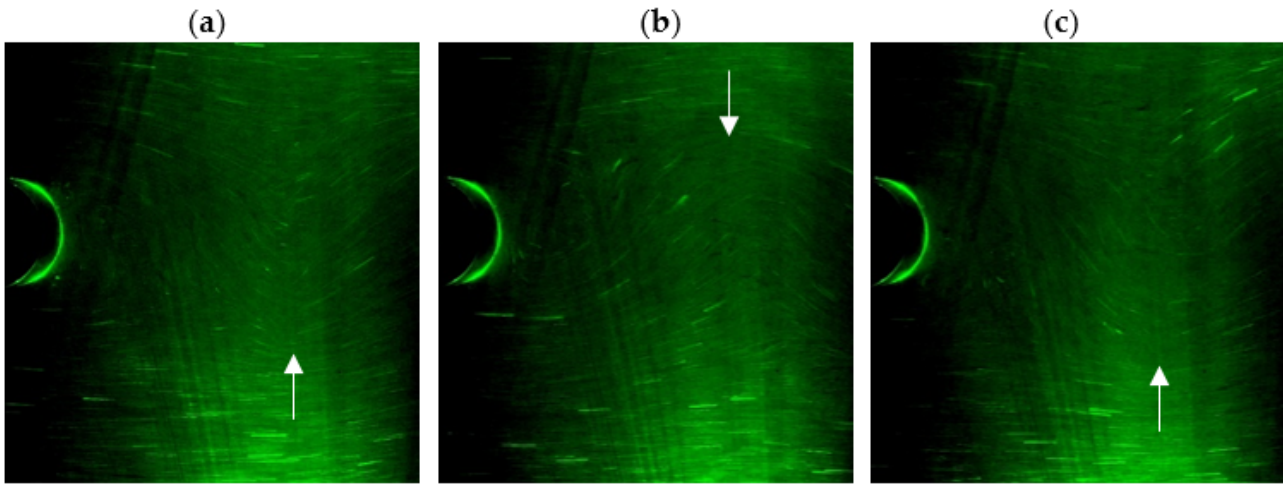
Figure 14. Sequence of consecutive photos ( a ) t 0 = 66, ( b ) t i =76, ( c ) t 2 = 86.